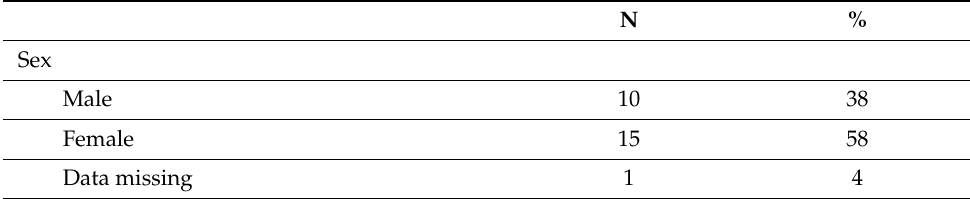
Table 2. Characteristics of the 26 GPs included in the quantitative